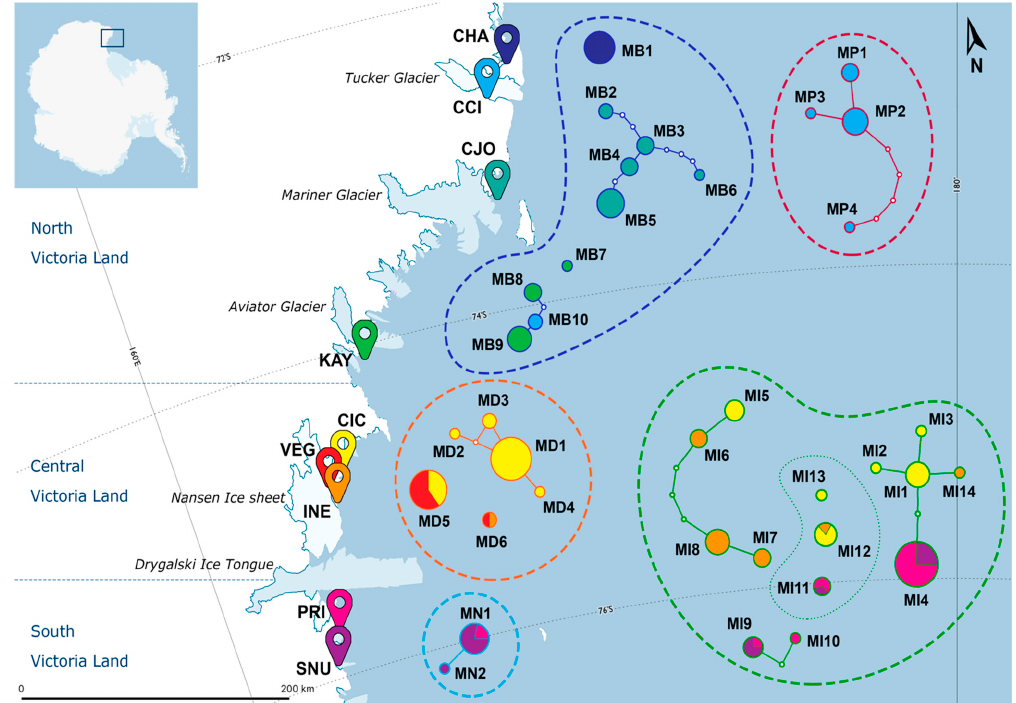
Figure 2. Haplotype networks of cox1 for the five Stereotydeus species in Victoria Land (from 72 °S to 76 °S). Collection sites are indicated by the pie chart colors; the species are identified by the outlines of the networks together with the haplotype ID and the dashed lines around the clusters (coastlines from ADD Simple Basemap, NPI/Quantarctica 3 [60]).